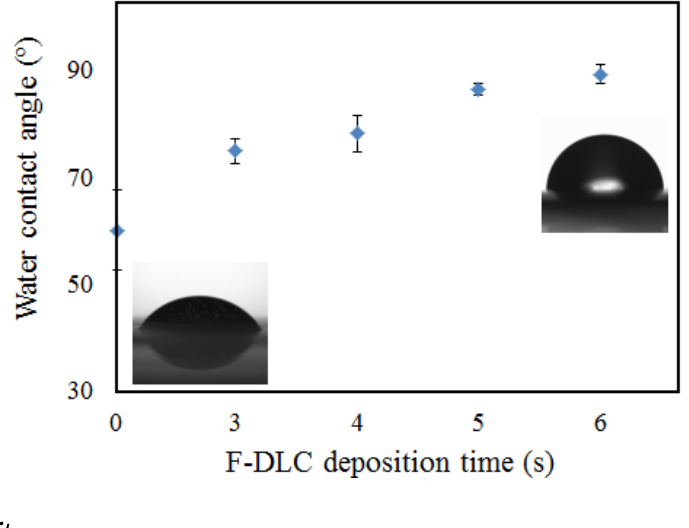
Figure 5. Water contact angle measurement of PES membranes and coated PES